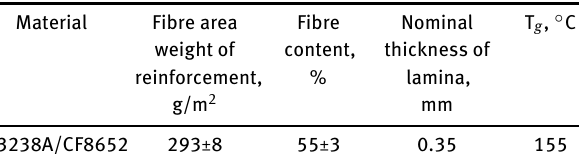
Table 1: Information of 3238A/CF8652 prepregs